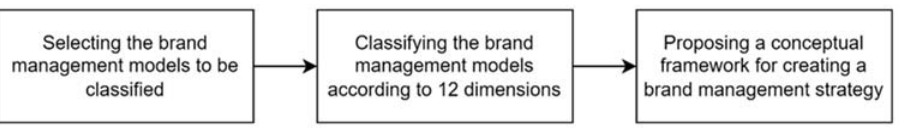
Figure 1. Methodology for proposing a conceptual framework for creating a brand management strategy.